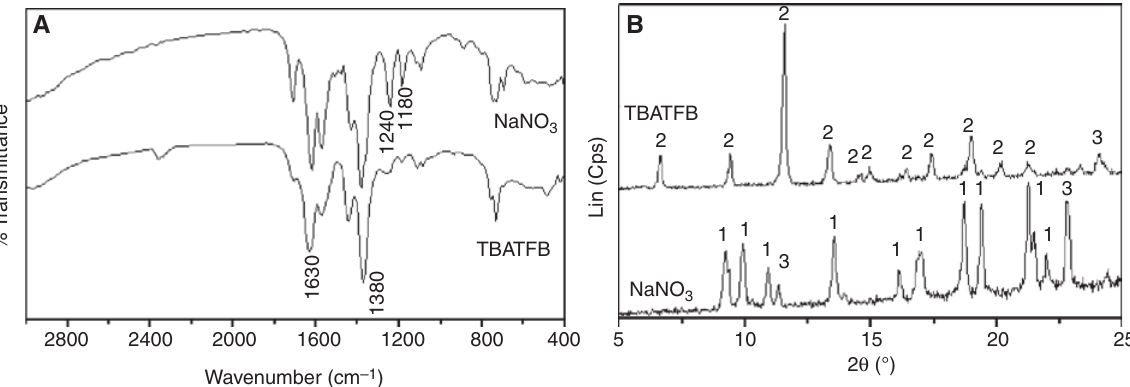
Figure 4: (A) IR spectra and (B) X-ray diffraction pattern of Cu-BTC, formed from Cu and benzene-1,3,5-tricarboxylic acid, synthesized with